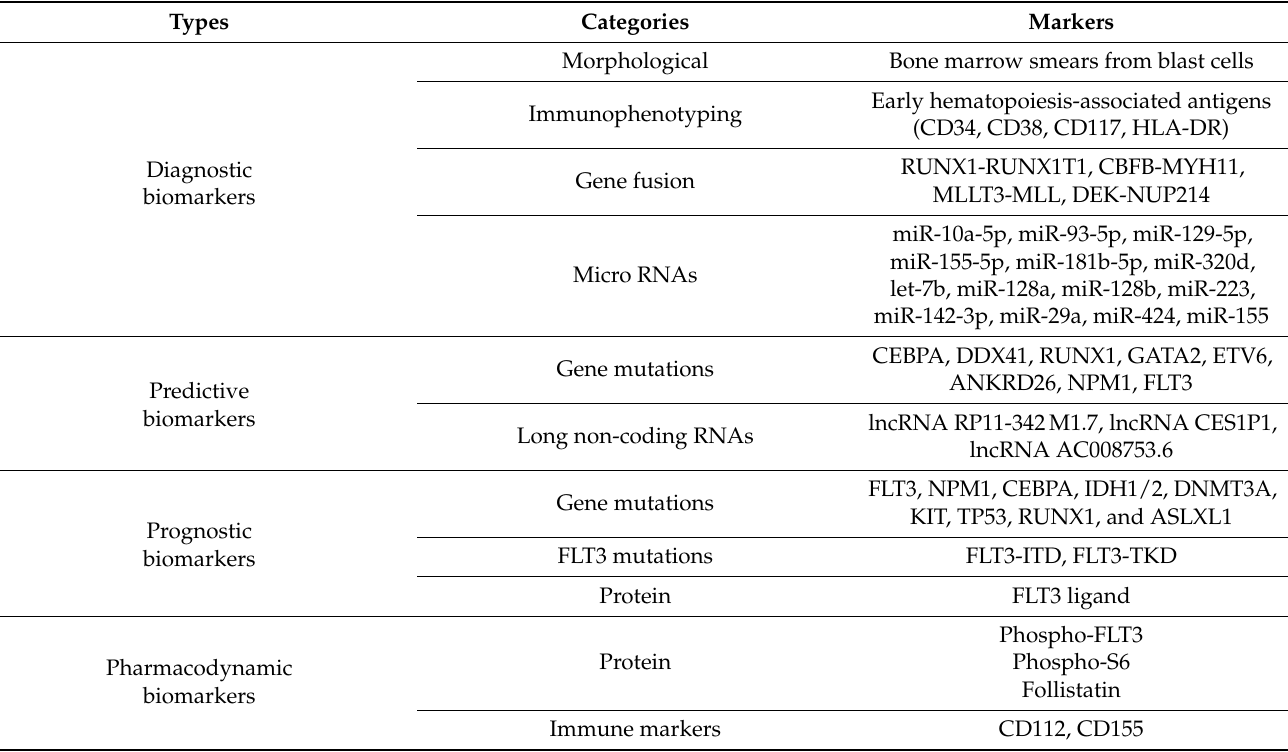
Table 3. Biomarkers for FLT3